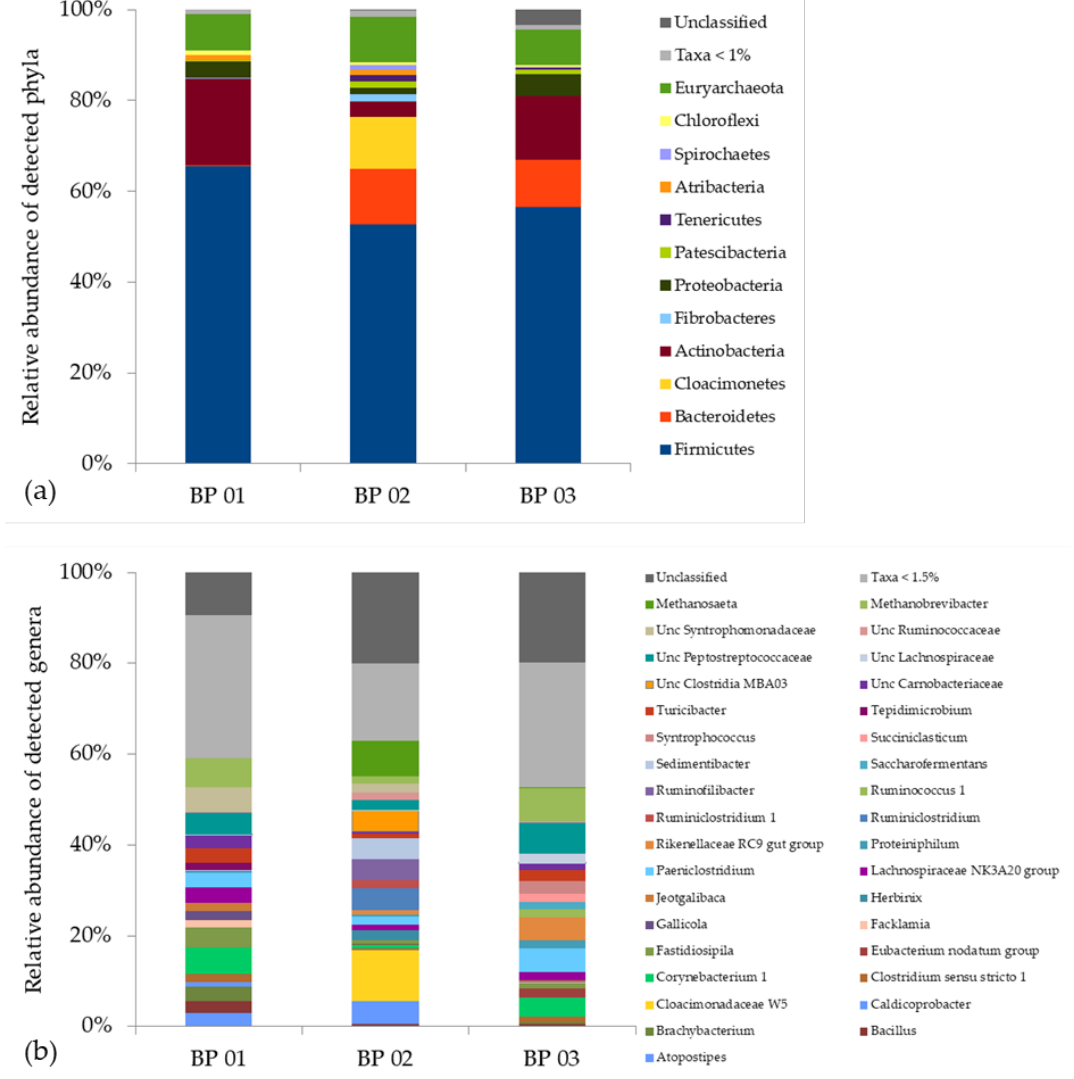
Figure 2. Taxonomic profiles of the main fermenter microbiomes of the analyzed biogas plants BP 01, BP 02 and BP 03 at the phylum ( a ) and genus ( b ) level after a three-month lasting lead time. In BP 01, 92.0% of the recorded OTUs were assigned to the domain Bacteria and 7.9% to the domain